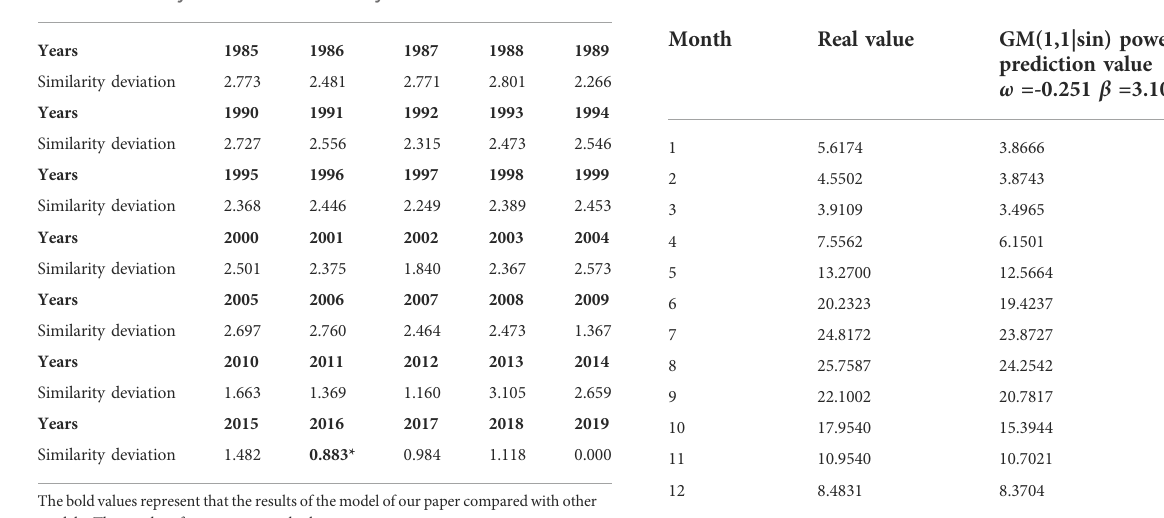
TABLE 6 Prediction results in 2020.